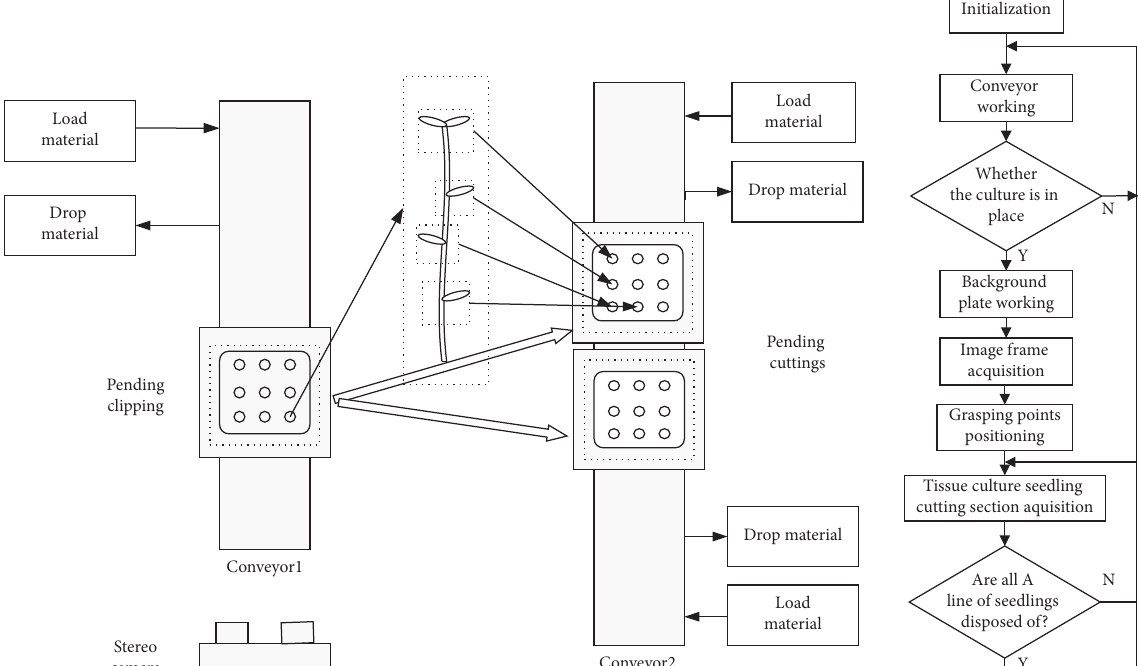
Figure 2: Workflow diagram of the vision